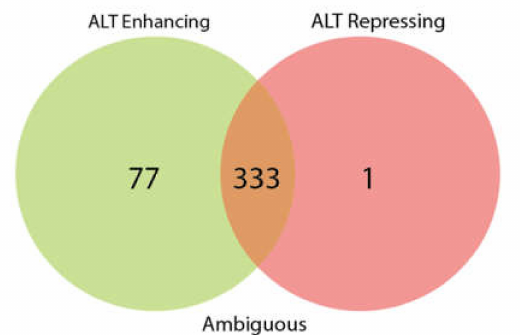
Figure 1. Role of the gene set in the ALT mechanism. The 411 gene set selected for this study was filtered according of their alternative lengthening of telomeres (ALT) activity in the TelNet database and classified as enhancers, repressors or